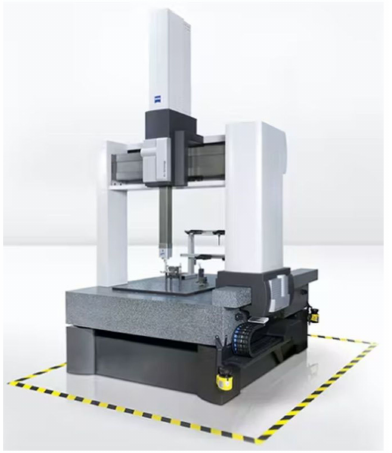
Figure 2. CMM (Coordinate Measuring